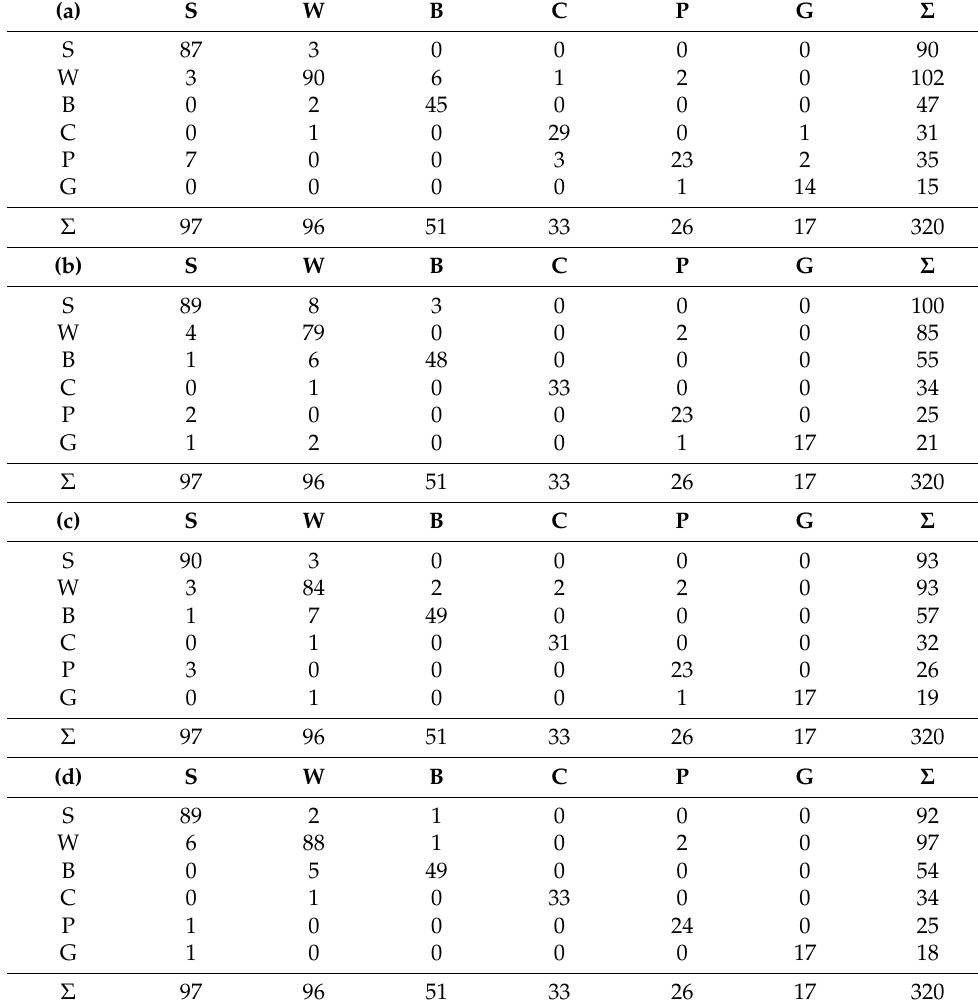
Table 5. Confusion matrices generated with the ground reference data; actual class of membership shown in the columns. ( a ) for the discriminant analysis, ( b ) for the decision tree, ( c ) for the neural network and ( d ) for the support vector machine. Data from